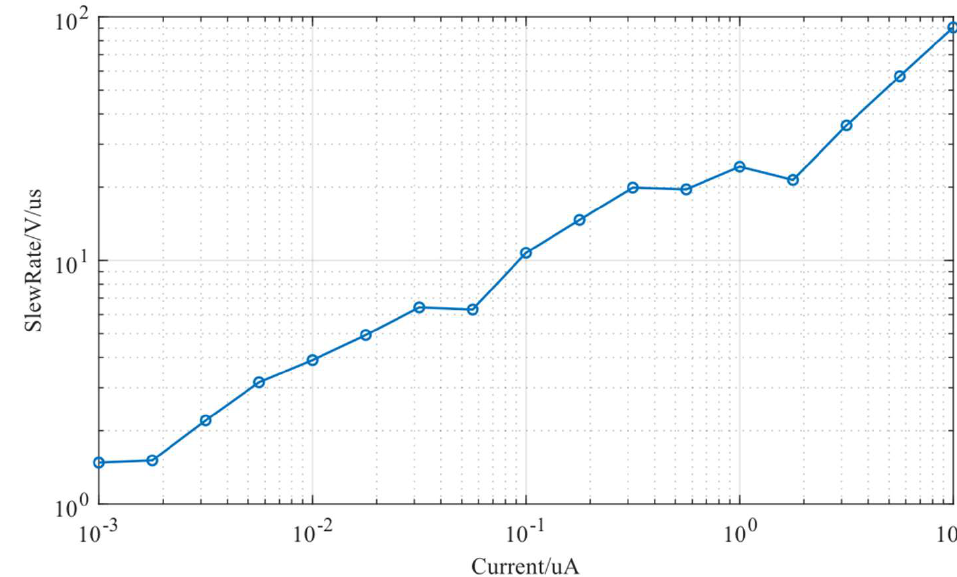
Figure 8. Dynamically increase the Slew Rate.